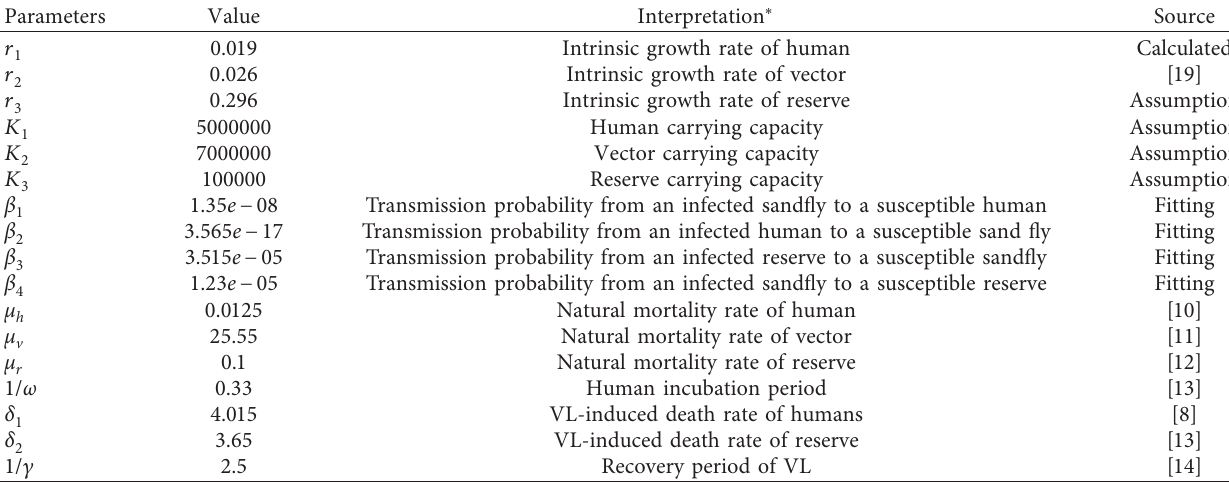
Table 1: Parameter values (and their sources).